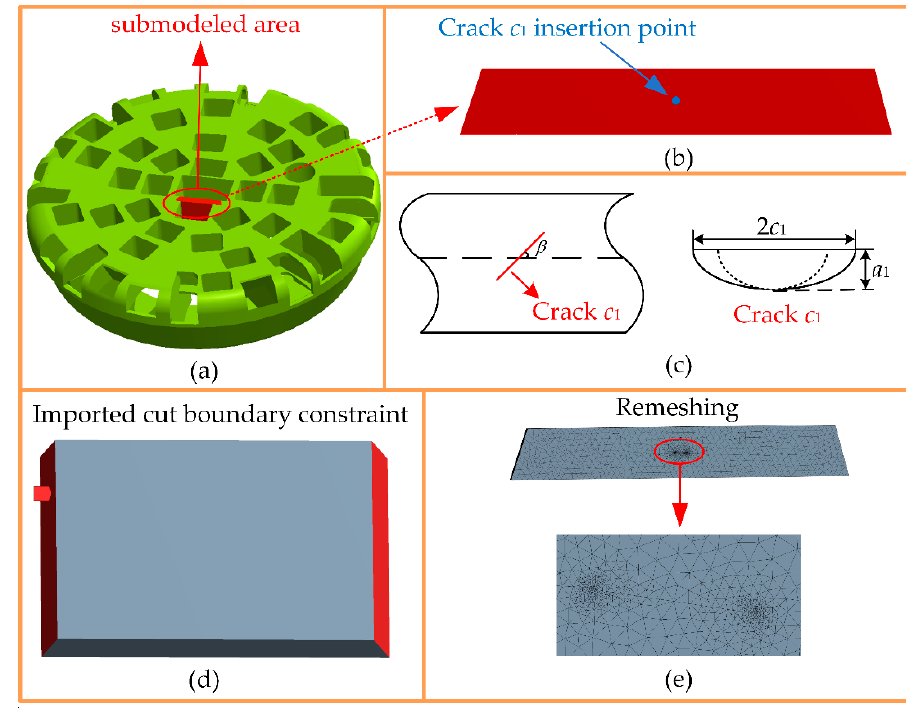
Figure 3. Submodeling technical schematic: ( a ) schematic diagram of the submodeled area, ( b ) schematic diagram of the crack insertion point, ( c ) schematic diagram of the crack position angle and shape parameter, ( d ) the boundary conditions, and ( e ) the crack grid after remeshing.